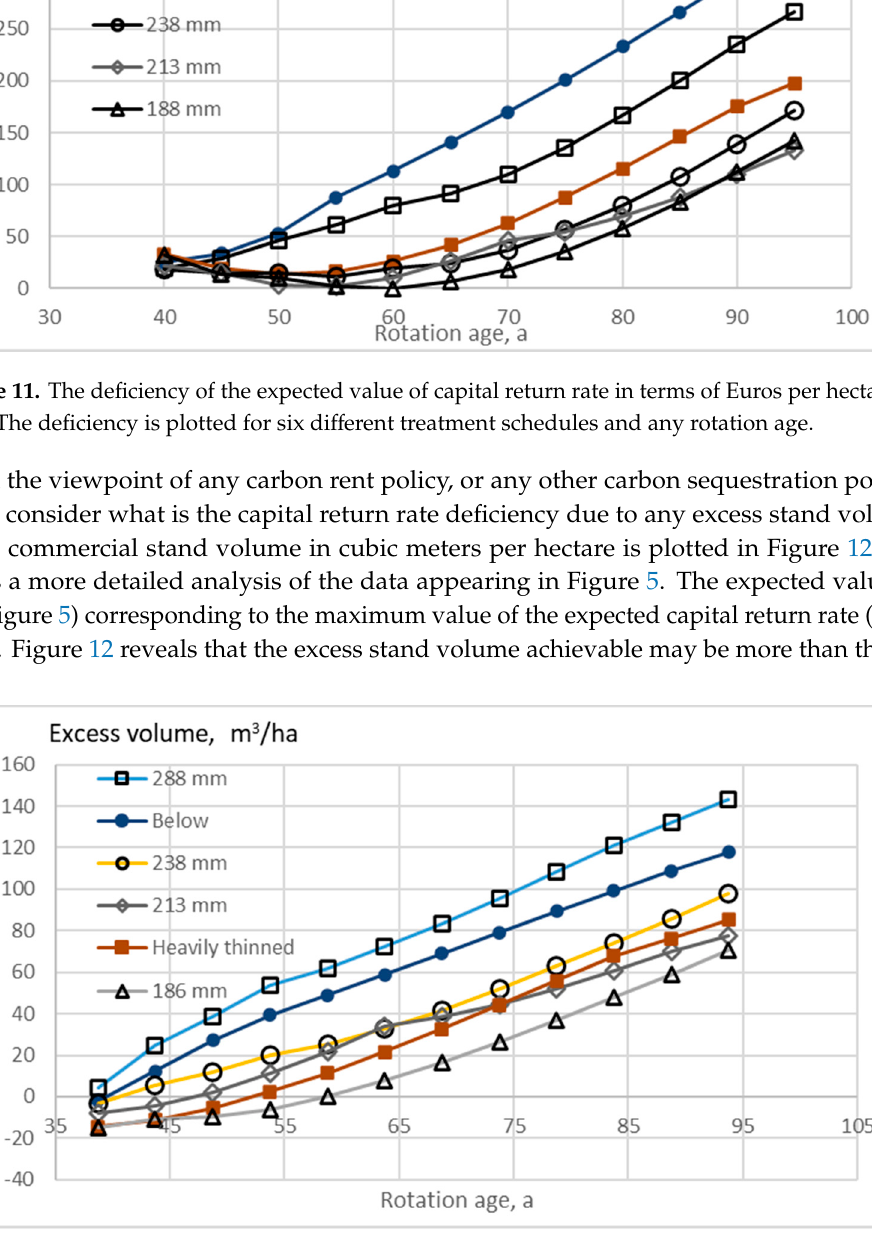
Figure 12. The expected value of stand volume over the stand volume providing the greatest expected value of capital return rate according to Equation (7) and Figure 3. The excess volume is plotted for six different treatment schedules and any rotation age.